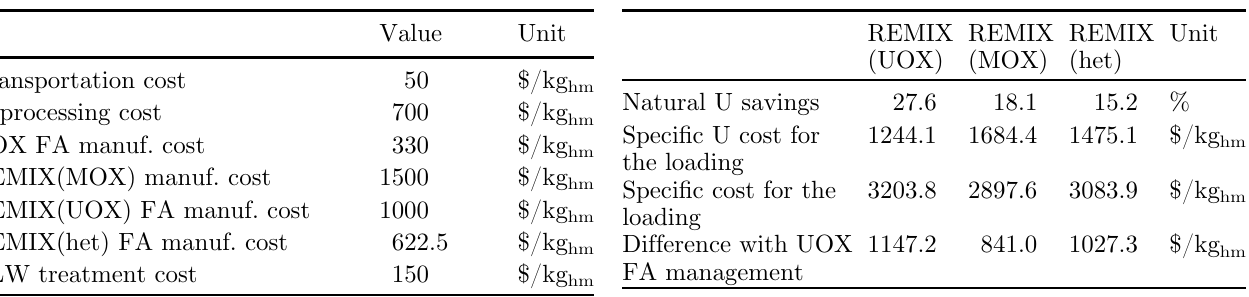
Table 4. Speci fi c costs of manufacturing processes for REMIX FA fabrication.